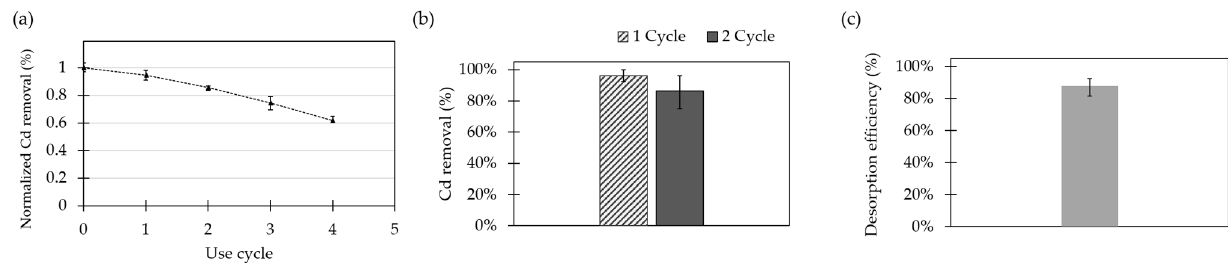
Figure 7. Percentage of Cd removal per cycle of Fe 3 O 4 NPs @APTES ( a ) without desorption between cycles; ( b ) after desorption of surfaces by 0.1% ( v / v ) HCl solutions as regenerating agent; and ( c ) desorption efficiency after regeneration treatment.